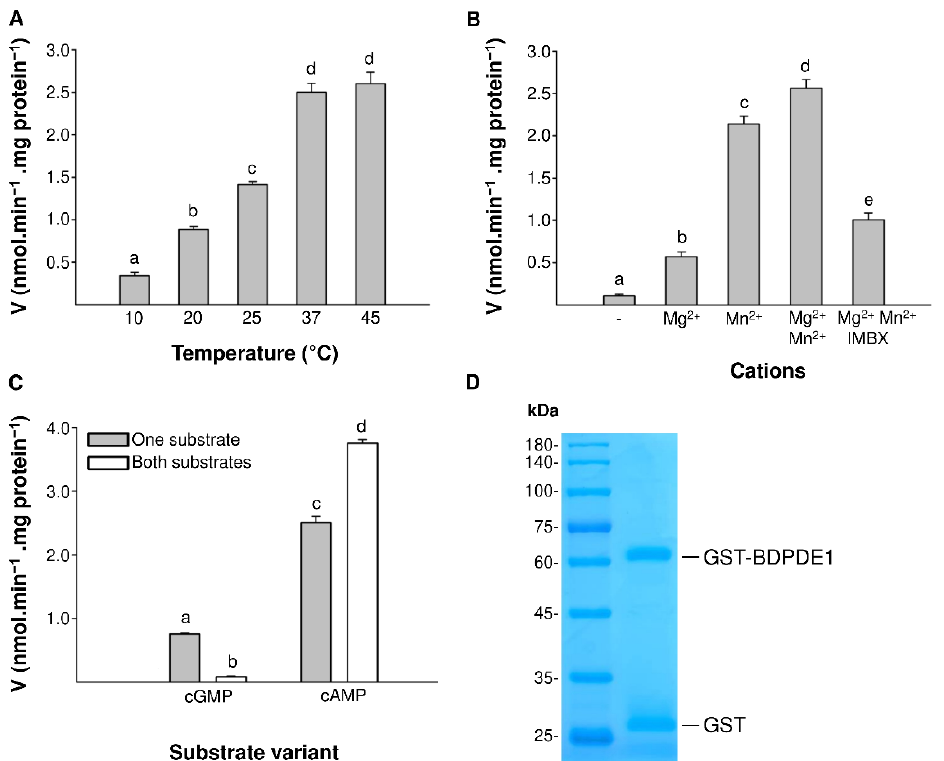
Figure 2. Characterization of the biochemical properties of BDPDE1. ( A ) Influence of temperature on the PDE activity. The enzymatic activity was tested in the temperature range from 10 ◦ C to 45 ◦ C. The reaction time was 25 min in the standard reaction mixture containing 0.1-mM cAMP and 5 µ g of GST-BDPDE1. ( B ) Effect of divalent cations and inhibitor on the PDE activity of GST-BDPDE1. The reaction was carried out in the standard reaction mixture containing 0.1-mM cAMP, 5 µ g of GST-BDPDE1 and, depending on the reaction variant, 0.5-mM MgCl 2 and/or MnCl 2 , and 50- µ M IMBX was added. ( C ) Substrate specificity of GST-BDPDE1. The reaction was performed in the presence of 5 µ g of GST-BDPDE1, and depending on the substrate variant, 0.1-mM cAMP and/or 0.1-mM cGMP was added. In all the error bars, different letters indicate significant differences at p < 0.05. ( D ) The purified GST-BDPDE1 protein (4 µ g) was analyzed by